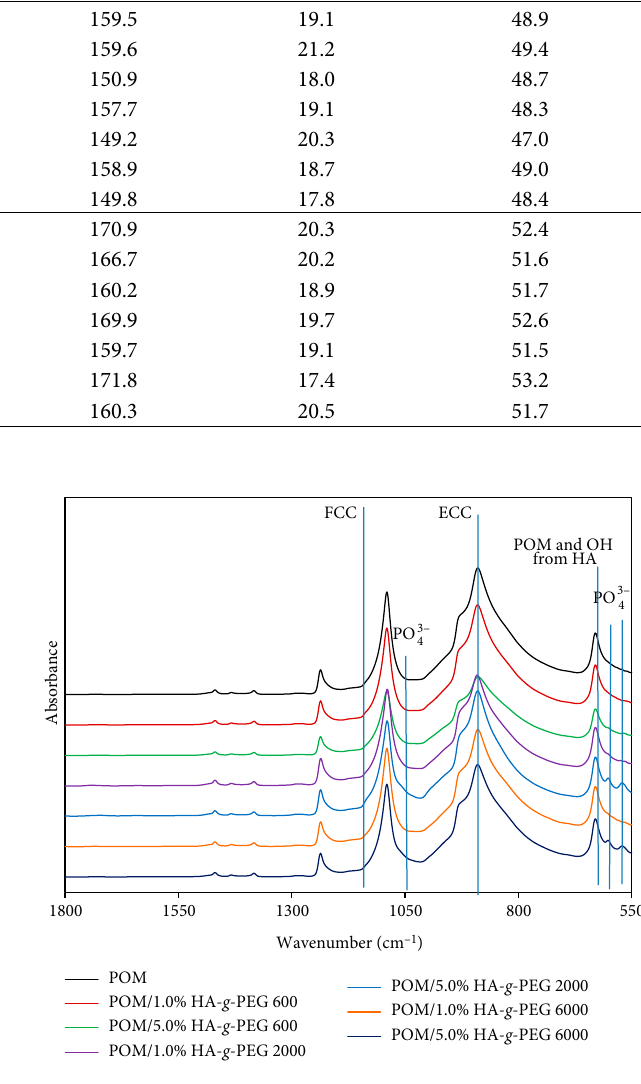
Figure 6: FTIR-ATR spectra of POM/HA- g -PEG